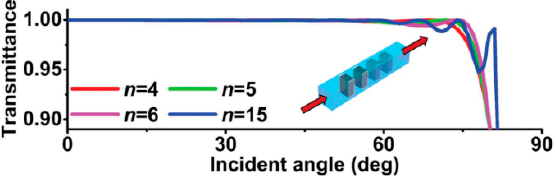
Figure 14. Incident-angle-dependent transmittance of acoustic waves propagating through an acoustic metamaterial matching layer with n = 4, 5, 6, 15 unit cells. Reprinted with permission from [309], DOI: https://doi.org/10.1103/PhysRevMaterials.2.045201, Copyright (2018) by the American Physical Society.